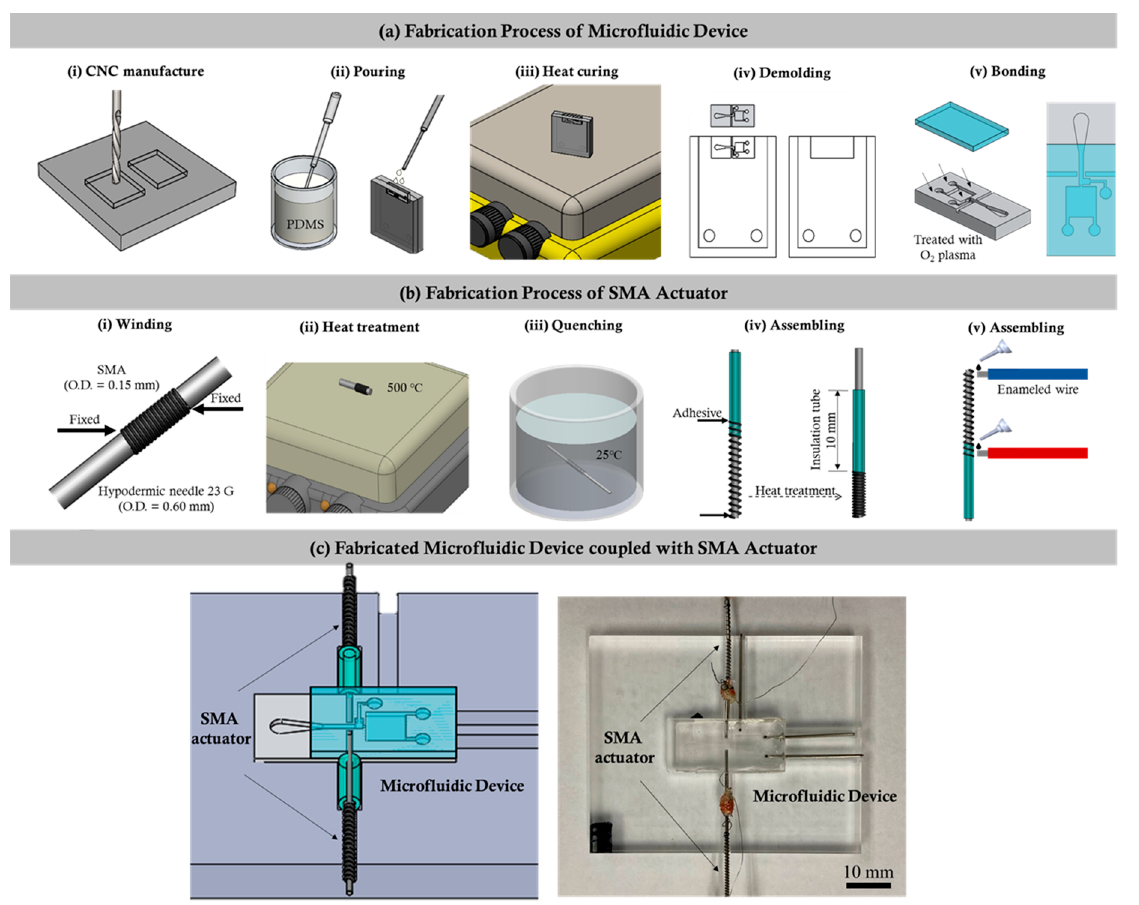
Figure 1. The fabrication process of the microfluidic and shape memory alloy (SMA) device. ( a ) i–v illustrates the various fabrication processes involved in the making of the proposed microfluidic device. ( b ) i–v illustrates the series of fabrication processes involved in the fabrication of the SMA device. ( c ) Illustration of the fabricated microfluidic device with the SMA integrated